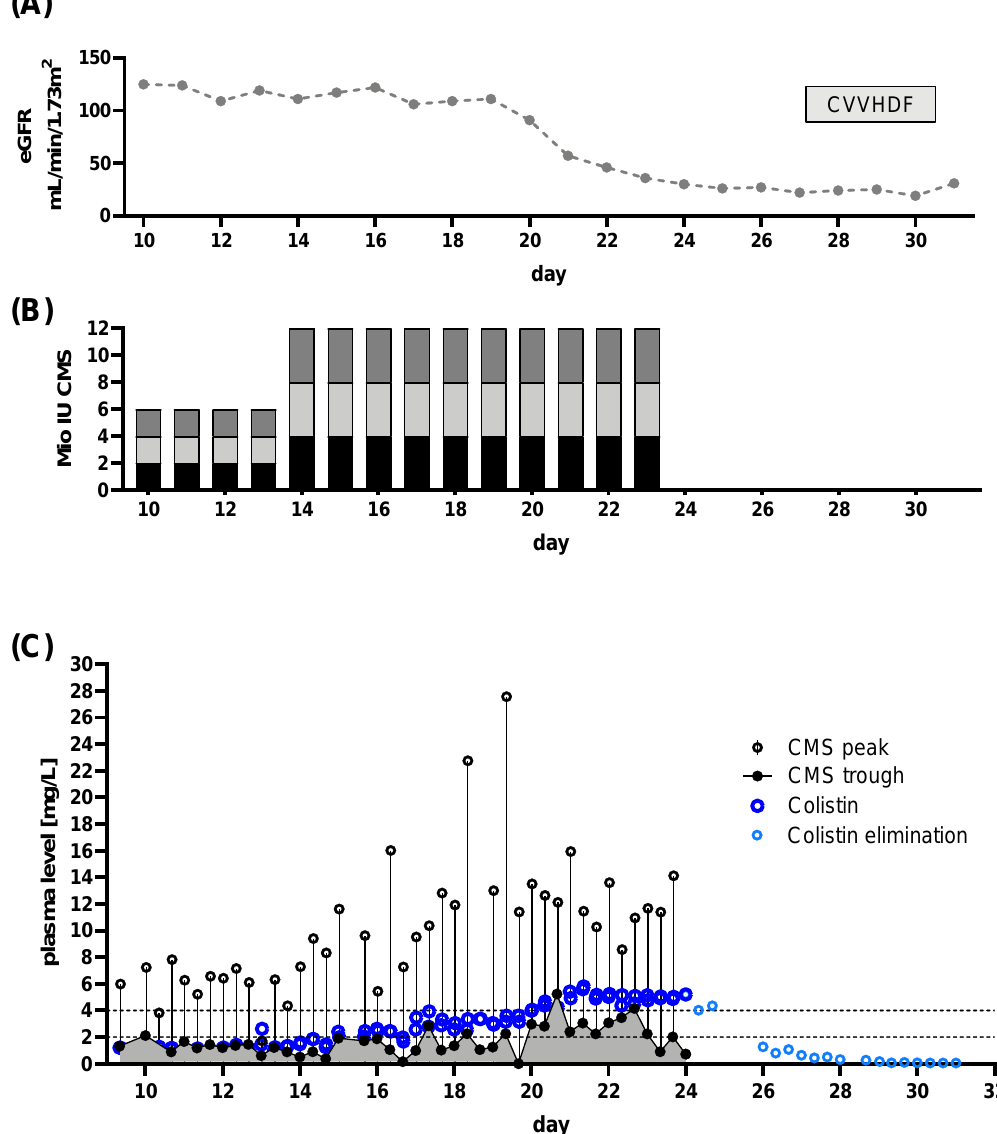
Figure 4. Renal function, dose regimen and drug plasma levels of patient 2: a total of 84 samples were analyzed (colisthimethate sodium (CMS) peak n = 42, CMS trough n = 42, Colistin peak n = 44, Colistin trough n = 43). ( A ) estimated glomerular filtration rate (eGFR) derived from serum creatinine levels and renal replacement therapy via continuous venovenous hemodiafiltration (CVVHDF. ( B ) Dose regimen used. Shaded blocks depict the particular individual doses each day. ( C ) Time course of CMS trough and peak levels along with Colistin levels. The CMS reservoir is indicated by the area gray shaded portion of panel ( C ). Colistin elimination was measured by continuing monitoring after the end of treatment (light blue dots) and the individual fitted elimination is plotted in Figure 1A. Target range for Colistin plasma levels is indicated by dashed lines.